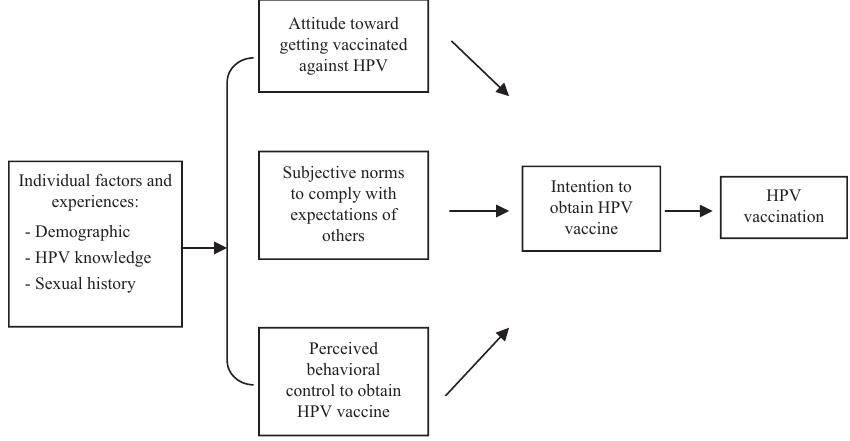
Figure 1. The study theoretical